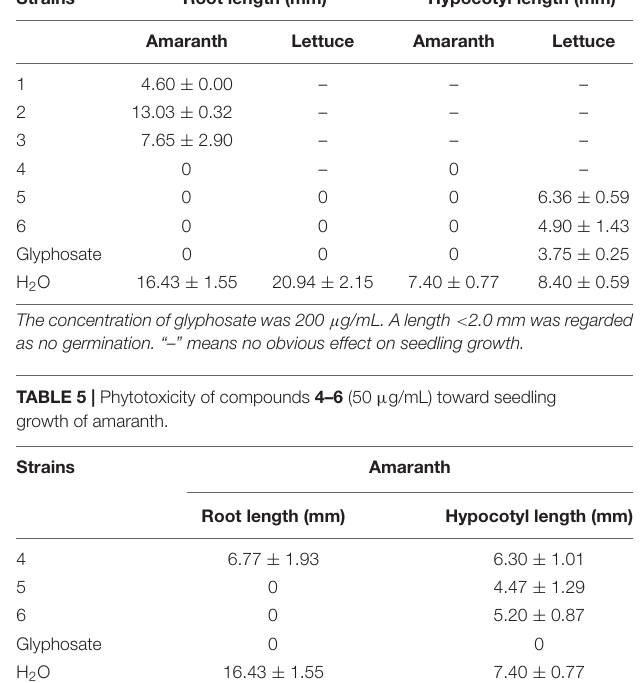
TABLE 4 | Phytotoxicity of compounds 1–6 (200 µ g/mL) toward seedling growth of amaranth and lettuce. Strains Root length